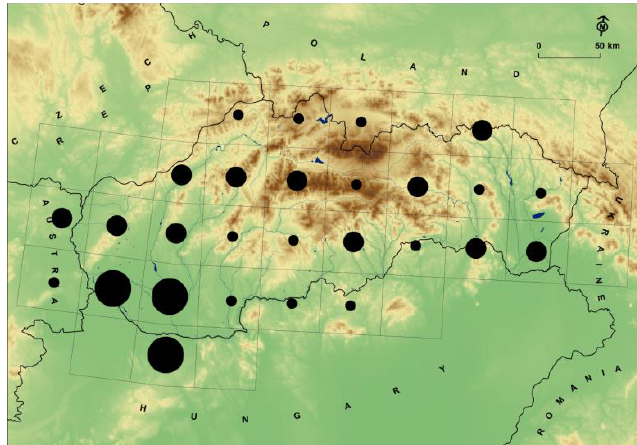
Figure 3. Distribution of charophytes in Slovakia: species richness in AFE grid cells(● 1–2 species, ● 3 – 5 species, and ● 6– 9 species).